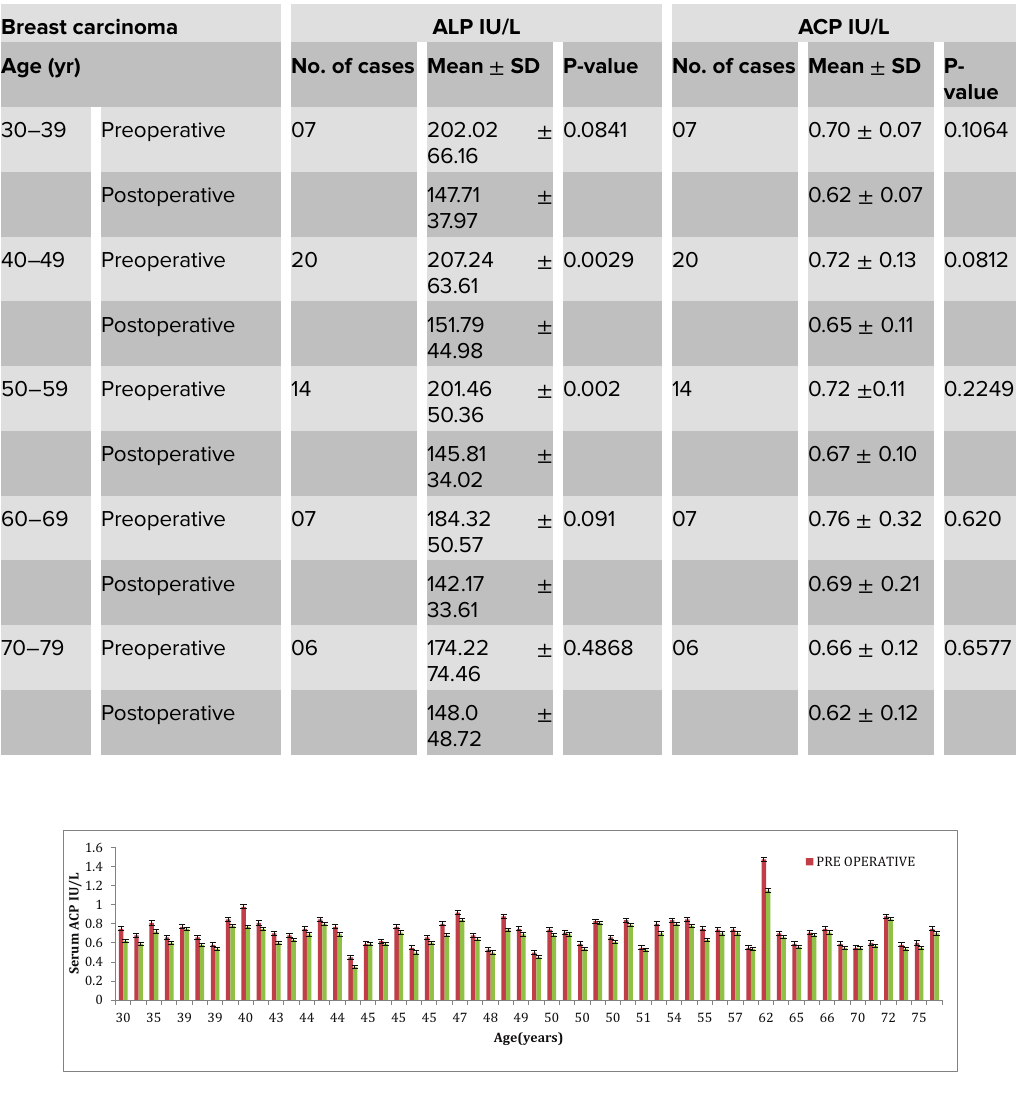
Figure 2 : Pre- and postoperative serum acid phosphatase levels in different age groups of breast